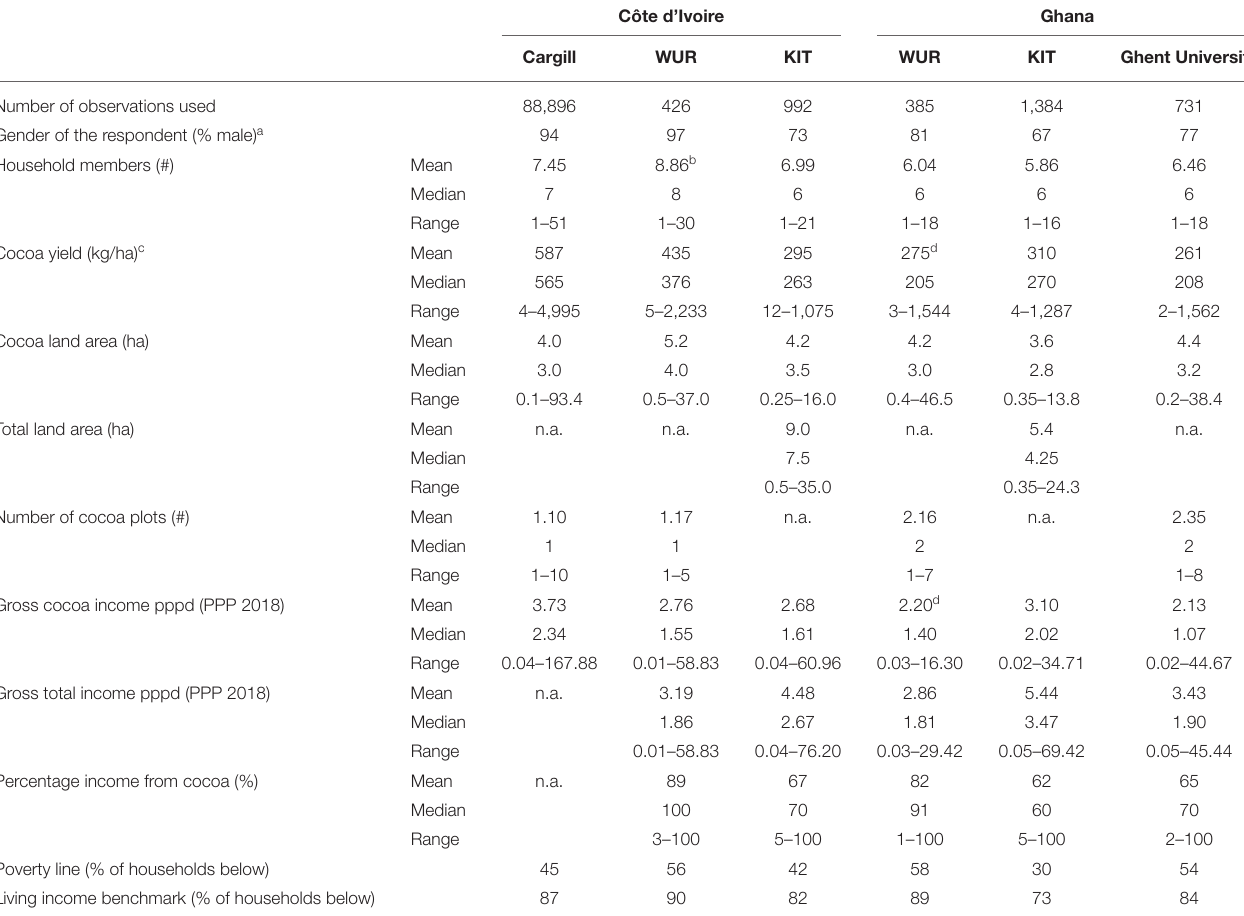
TABLE 3 | Summary of important variables calculated for each of the household survey data sets from Côte d’Ivoire and Ghana.